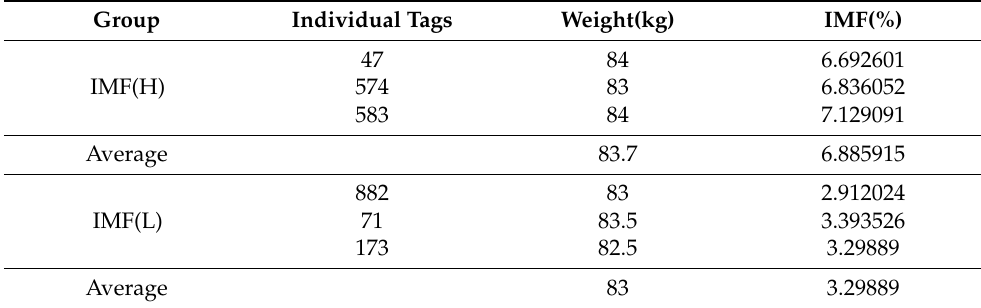
Phenotypic data of selected two groups of extreme intramuscular fat content of Erhualian